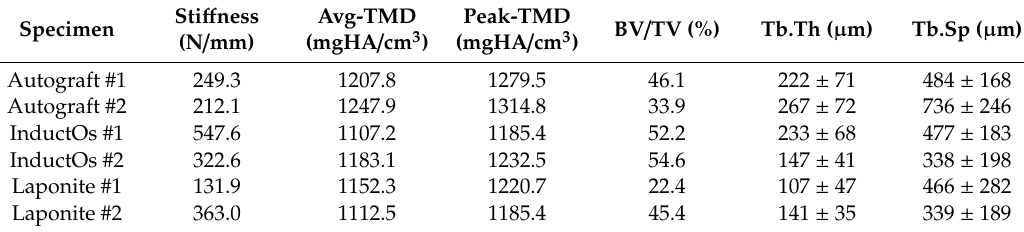
Table 1. Overview of the mechanical, mineral, and morphological parameters of the analyzed specimens. For each specimen, stiffness, average tissue mineral density (Avg-TMD), peak tissue mineral density (Peak-TMD), bone volume fraction (BV/TV), trabecular thickness (Tb.Th), and trabecular spacing (Tb.Sp) are detailed.